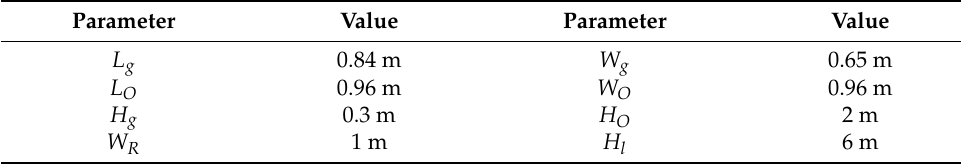
Table 1. Simulation parameters related to working